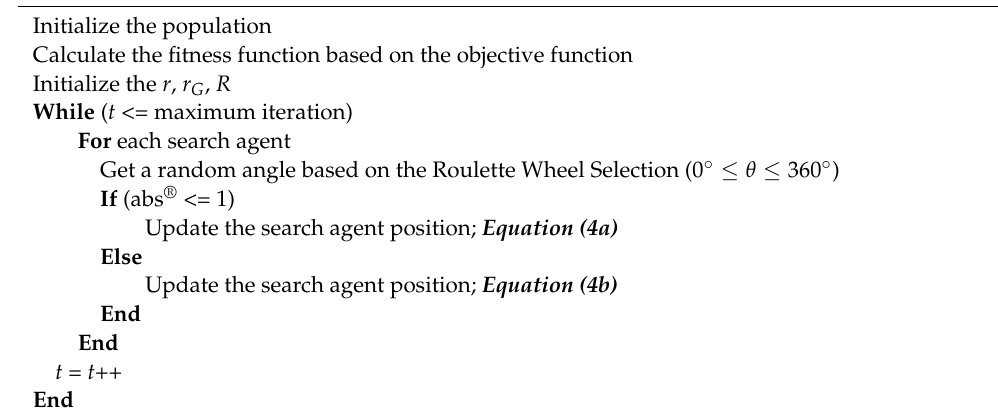
Algorithm 1. Sand cat swarm optimization algorithm